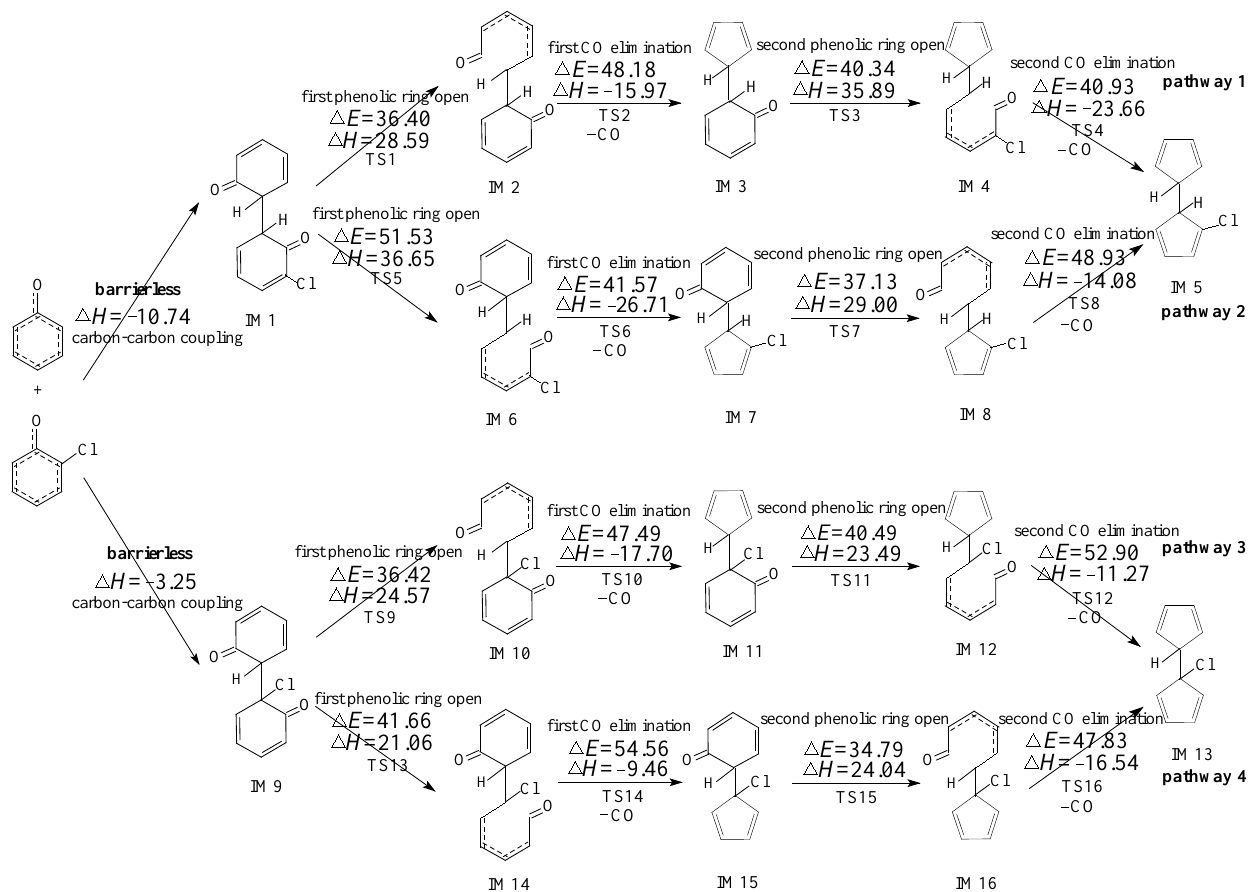
Figure 1. Chlorinated bicyclopentadienyl formation routes embedded with the potential barriers ∆ E (in kcal/moL) and reaction heats ∆ H (in kcal/moL) from the dimerization of PhR and 2 − CPR. ∆ H is calculated at 0